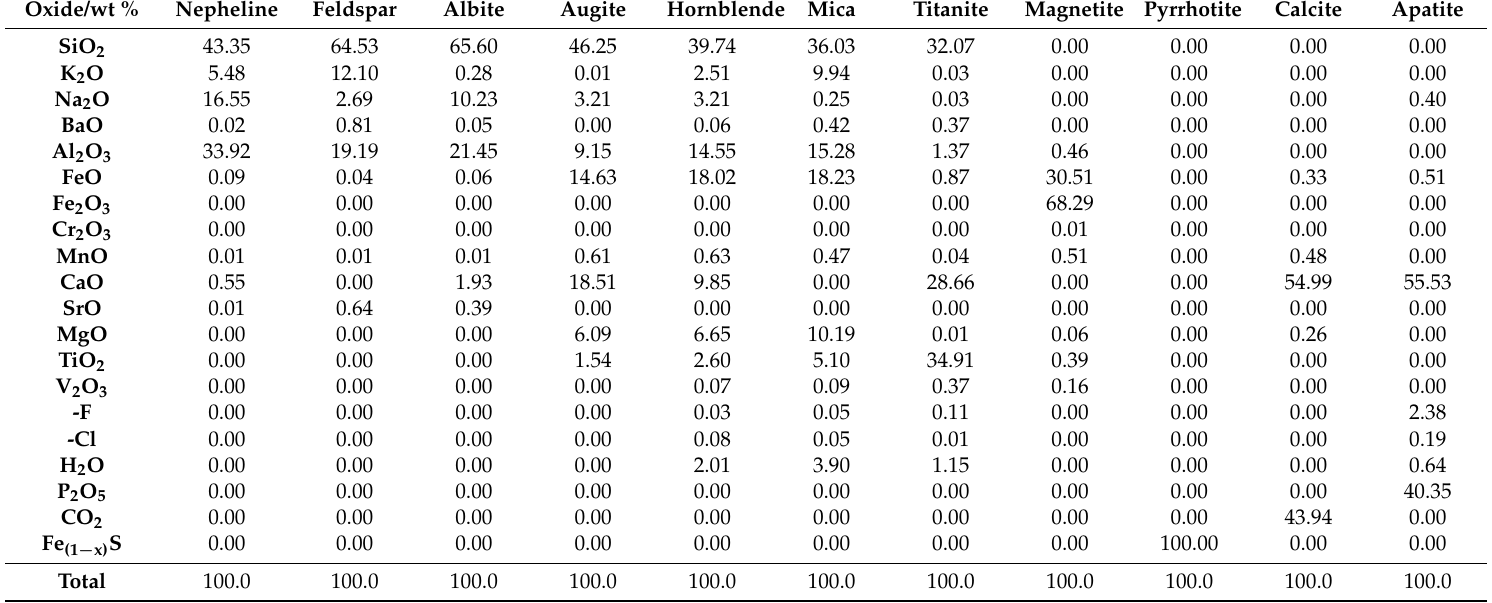
Table 6. Average mineral chemical compositions after normalization from minerals displayed in Table